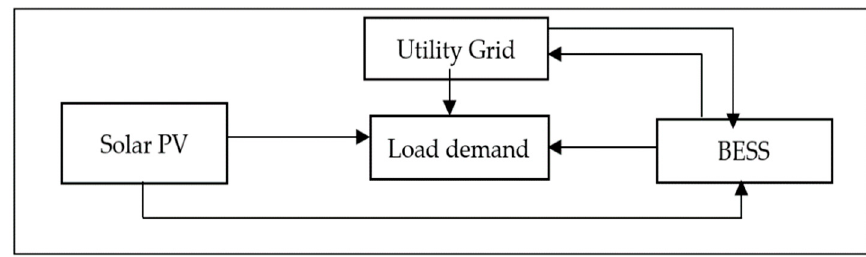
Figure 1. Illustration of grid-tied solar PV-battery microgrid.